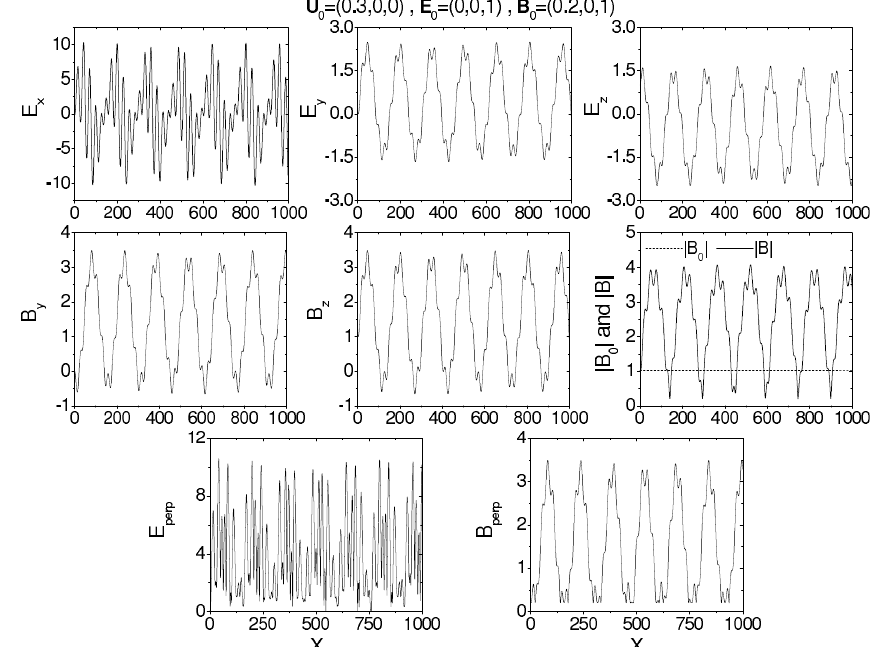
Fig. 11. Same as Fig. 10, however, shown in panels are the three components of electric wave-field ( E x , E y , E z ; top row); magnetic wave- field components ( B y and B z ) and total strengthes ( | B 0 | and | B | ) (middle row); and amplitudes of electric and magnetic fields in the plane perpendicular to the propagation direction ( E ⊥ and B ⊥ , lower row),